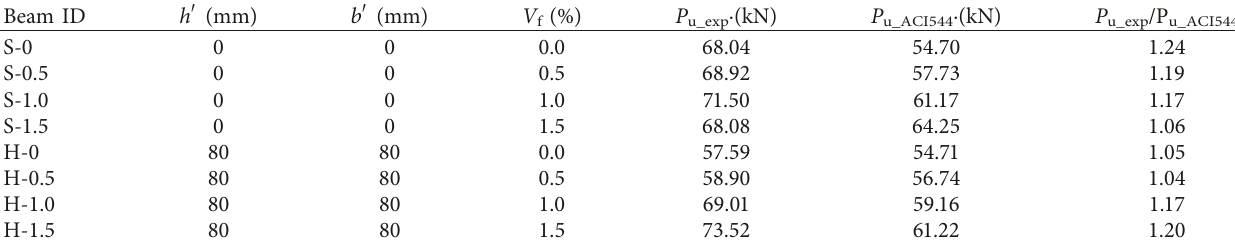
Figure 8: Typical stress and strain distribution in SFRC beams, according to ACI 544. Table 3: Experimental and predicted results of ultimate load capacity.